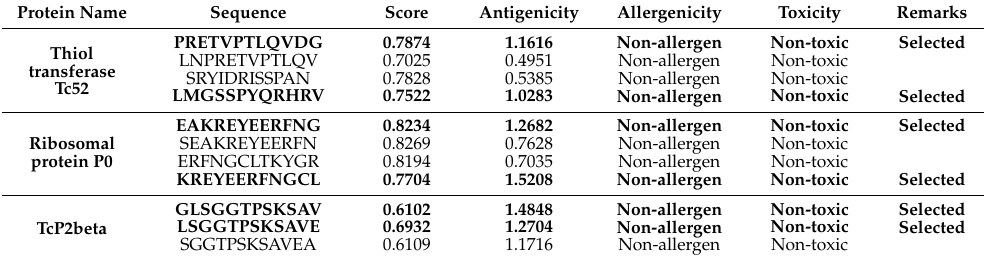
Table 4. Final LBL epitopes.